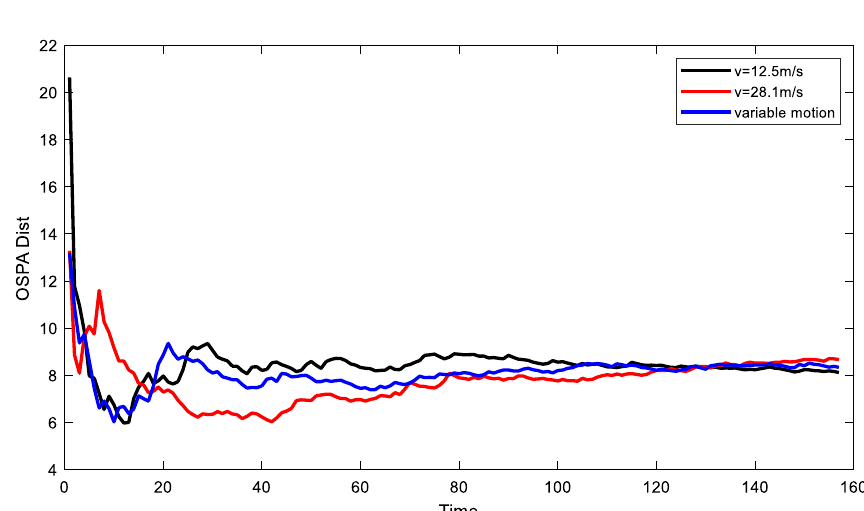
Fig. 8 OSPA performance